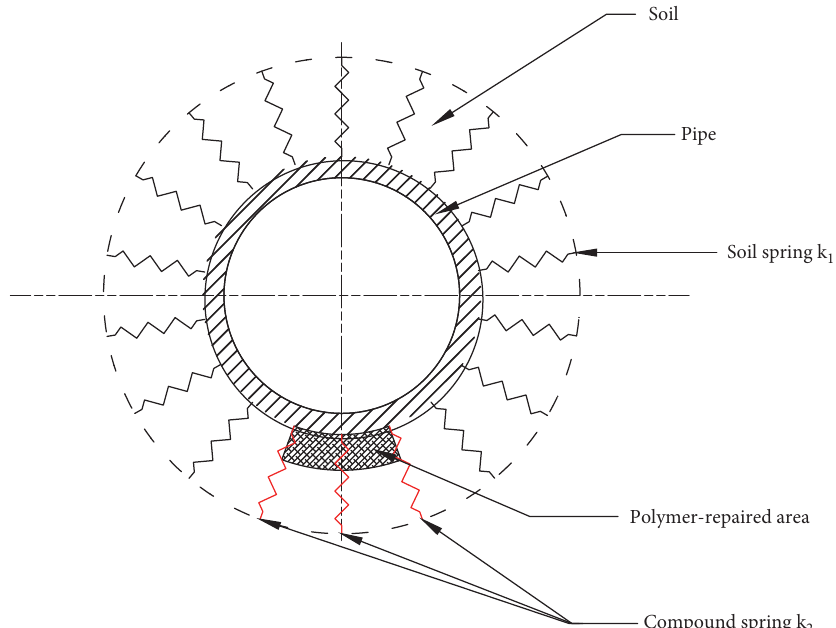
Figure 3: The Winkler model of pipe-soil-polymer